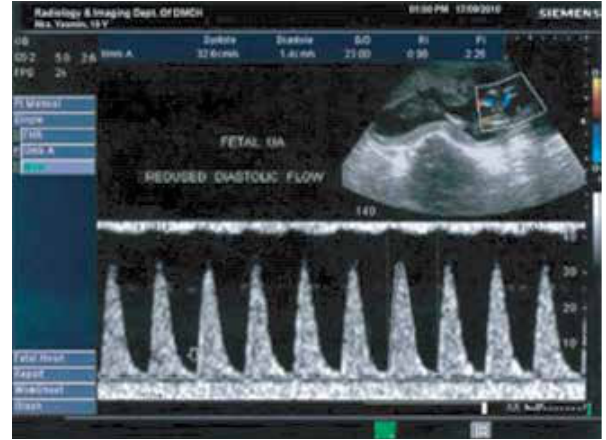
Fig 3. Abnormal umbilical artery waveform patterns showing markedly reduced diastolic flow